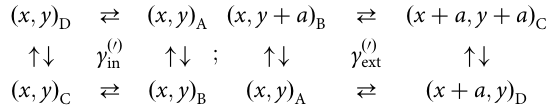
Fig. 2f systematically falls on the predicted exponential curve for Δ ϕ integer factor of 2 π